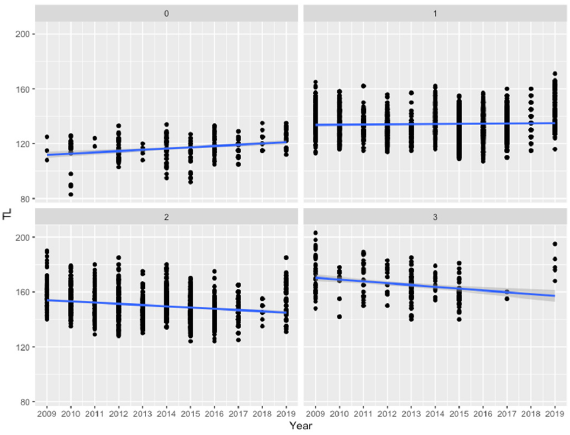
Figure 4. Temporal trend in the average length (Total length, TL in mm) per age class during the study period. Table 3. Linear regression carried out to detect TL trends among years by Age. Estimated coe ffi cients for each linear regression model were provided together with the F statistics for each age class.